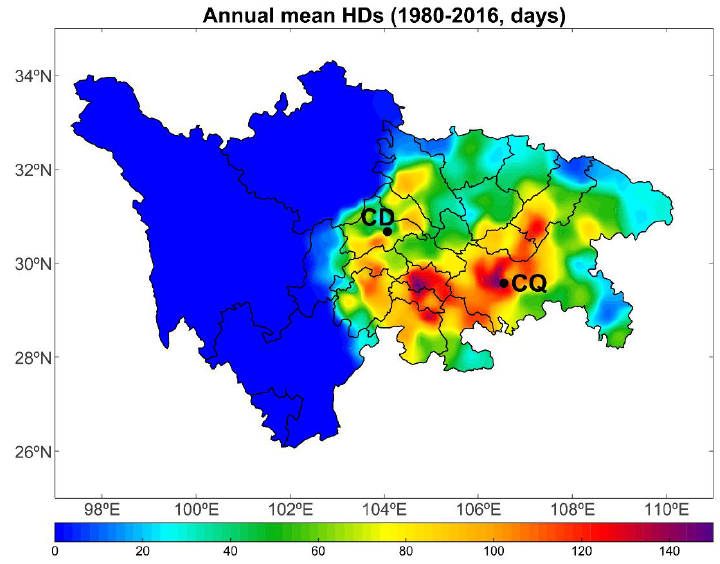
Figure 3. Spatial distributions of the annual mean HDs over the Sichuan-Chongqing region for 1980– 2016.